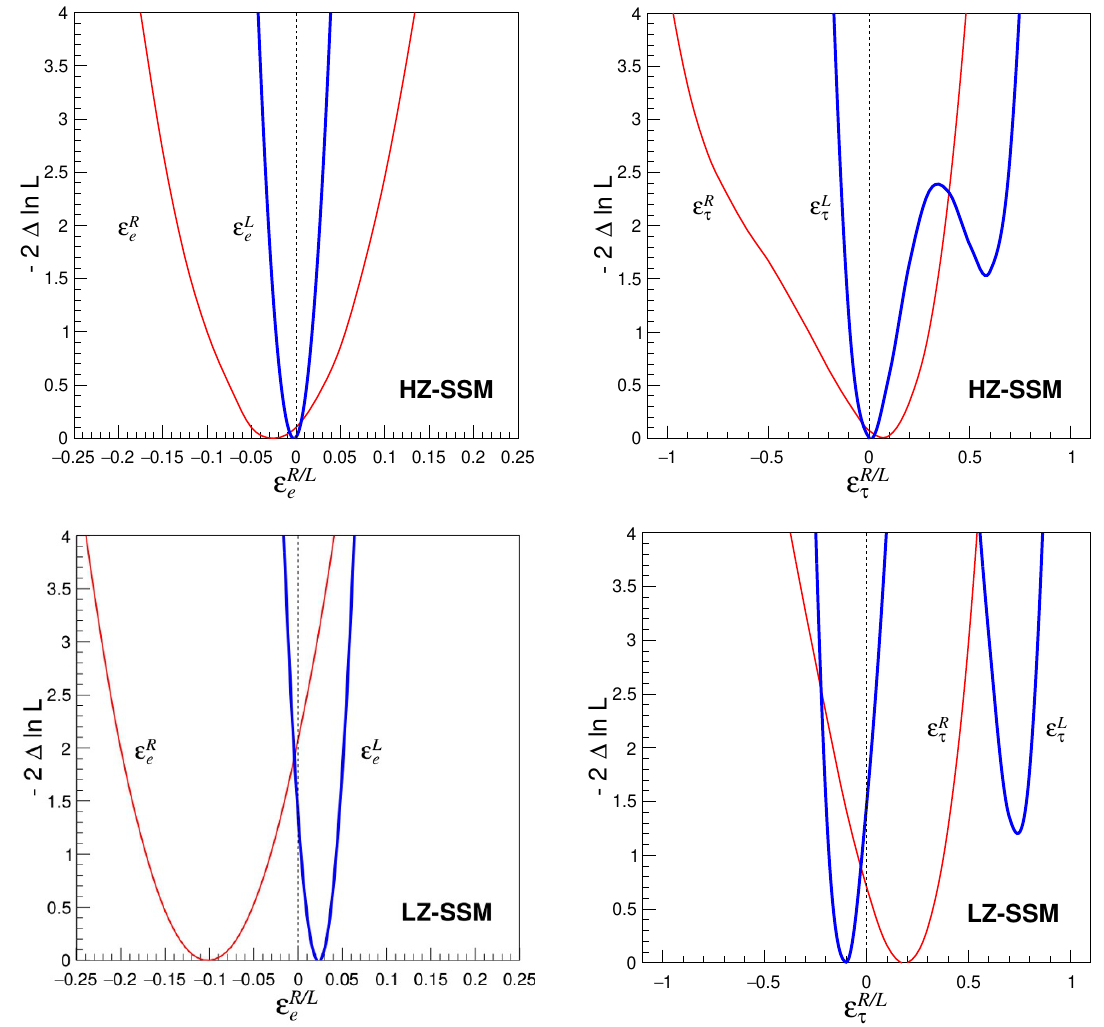
Figure 5 . Left panels show the log-likelihood pro(cid:12)les for the NSI parameter " R (blue line) assuming HZ (top panel) and LZ (bottom panel) SSM’s. Right panels depict the same for " R (red line) and " L (blue line). The pro(cid:12)les were obtained considering one NSI parameter (cid:28) (cid:28) at-a-time, while remaining NSI parameters were (cid:12)xed to